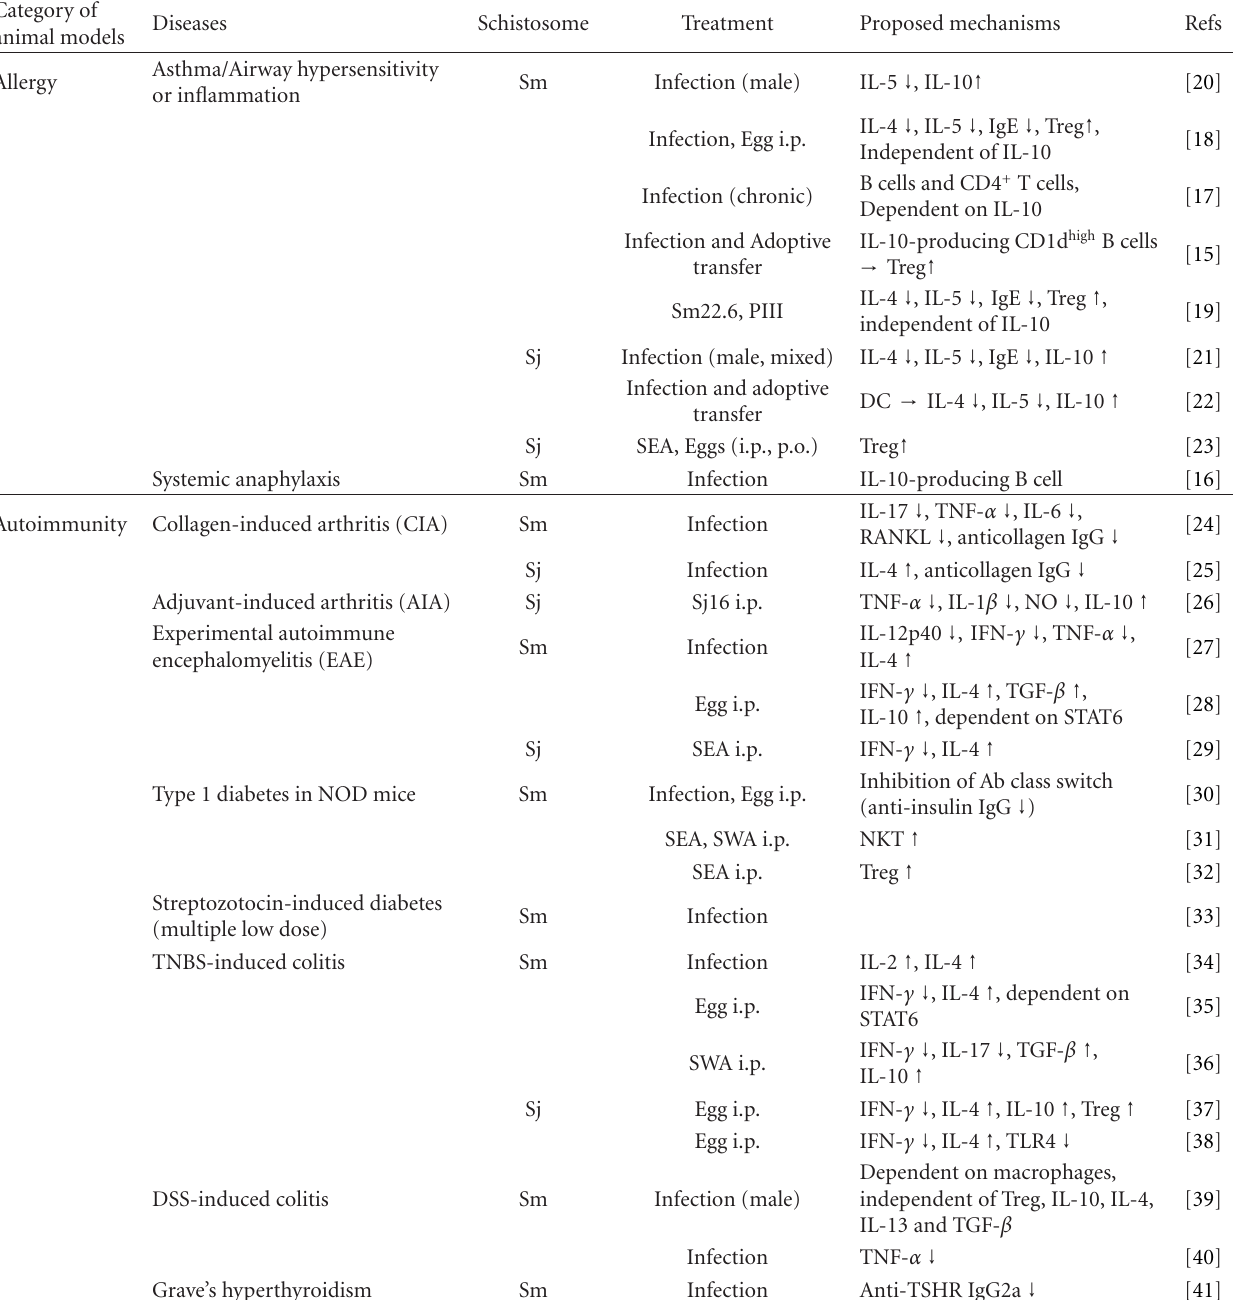
Table 1: Suppressive e ff ects of schistosome on experimental allergy and autoimmunity in